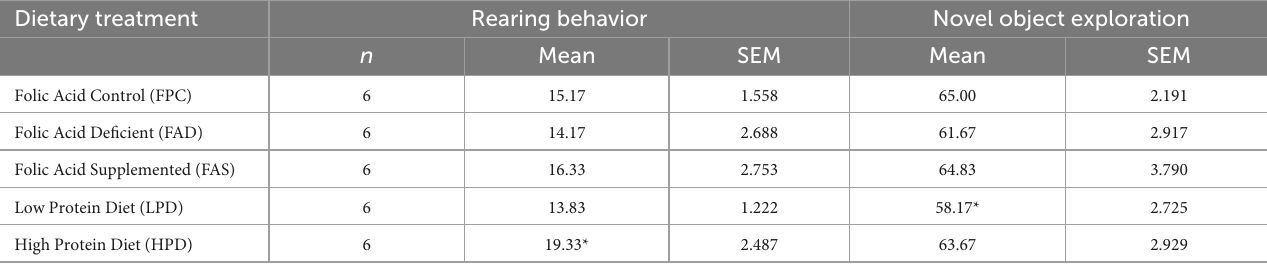
TABLE 2 Rearing and novel object exploratory behavior assessed in C57BL/6J mice over 7 weeks provided five different experimental diets ad libitum . Dietary